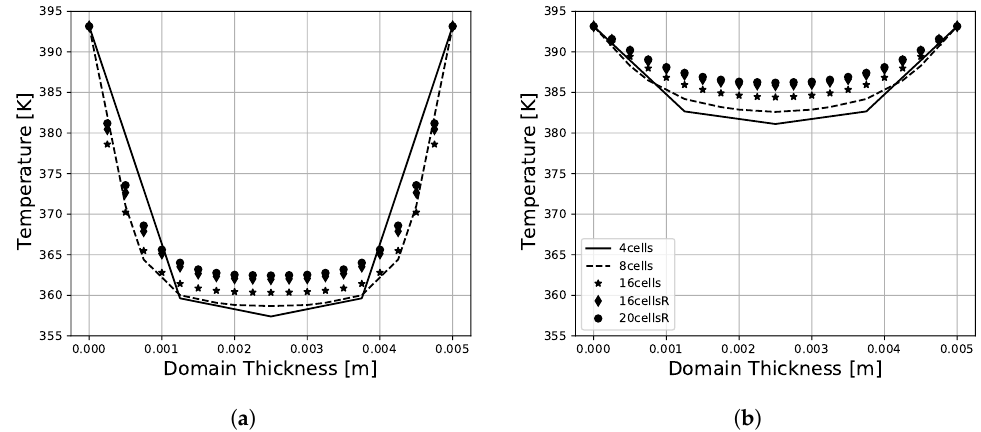
Figure 2. Temperature profiles at ( a ) x = 25mm and ( b ) x = 75mm from the inlet after the domain was fully infiltrated. Note that the legend in ( b ) is applicable to both figures.